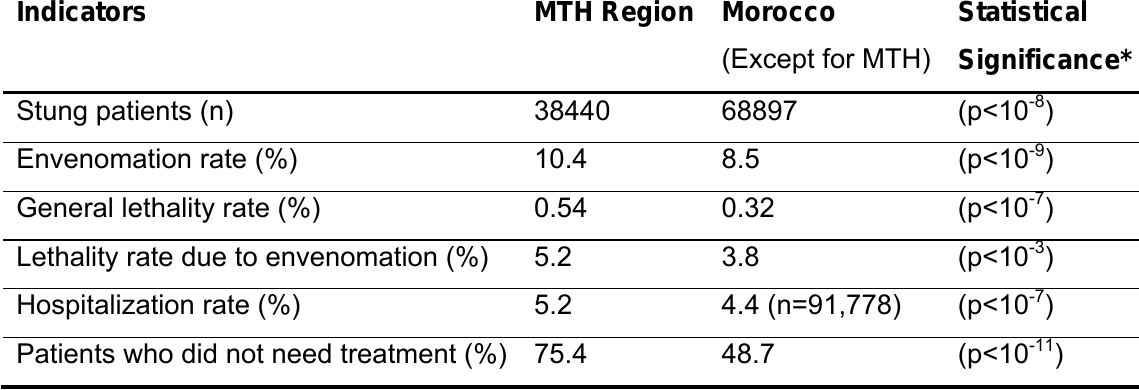
Table 4. Comparison of the evolutionary indicators of scorpion stings between Marrakech Tensift Al Haouz (MTH) region and